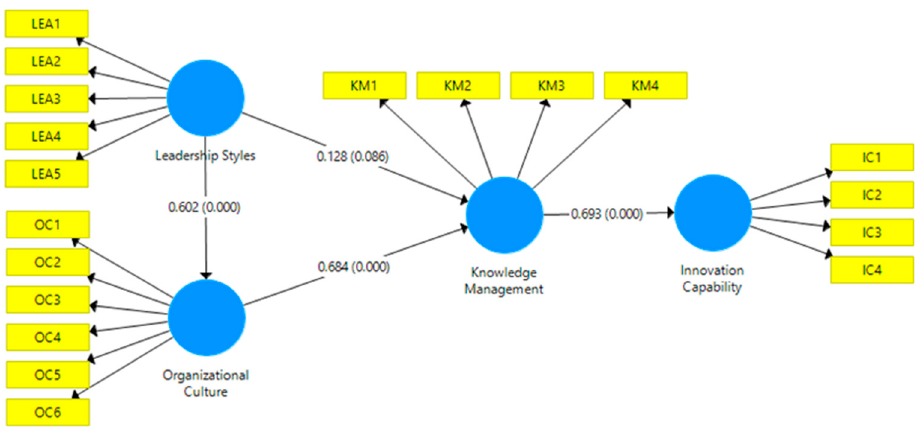
Figure 2. PLS-SEM results ( p -values in brackets) .